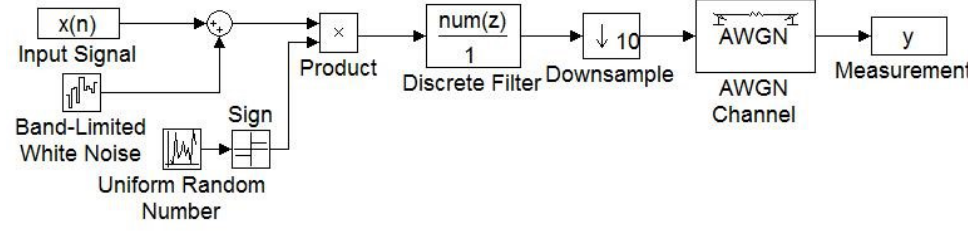
Figure 3. The RD-based AIC system model in